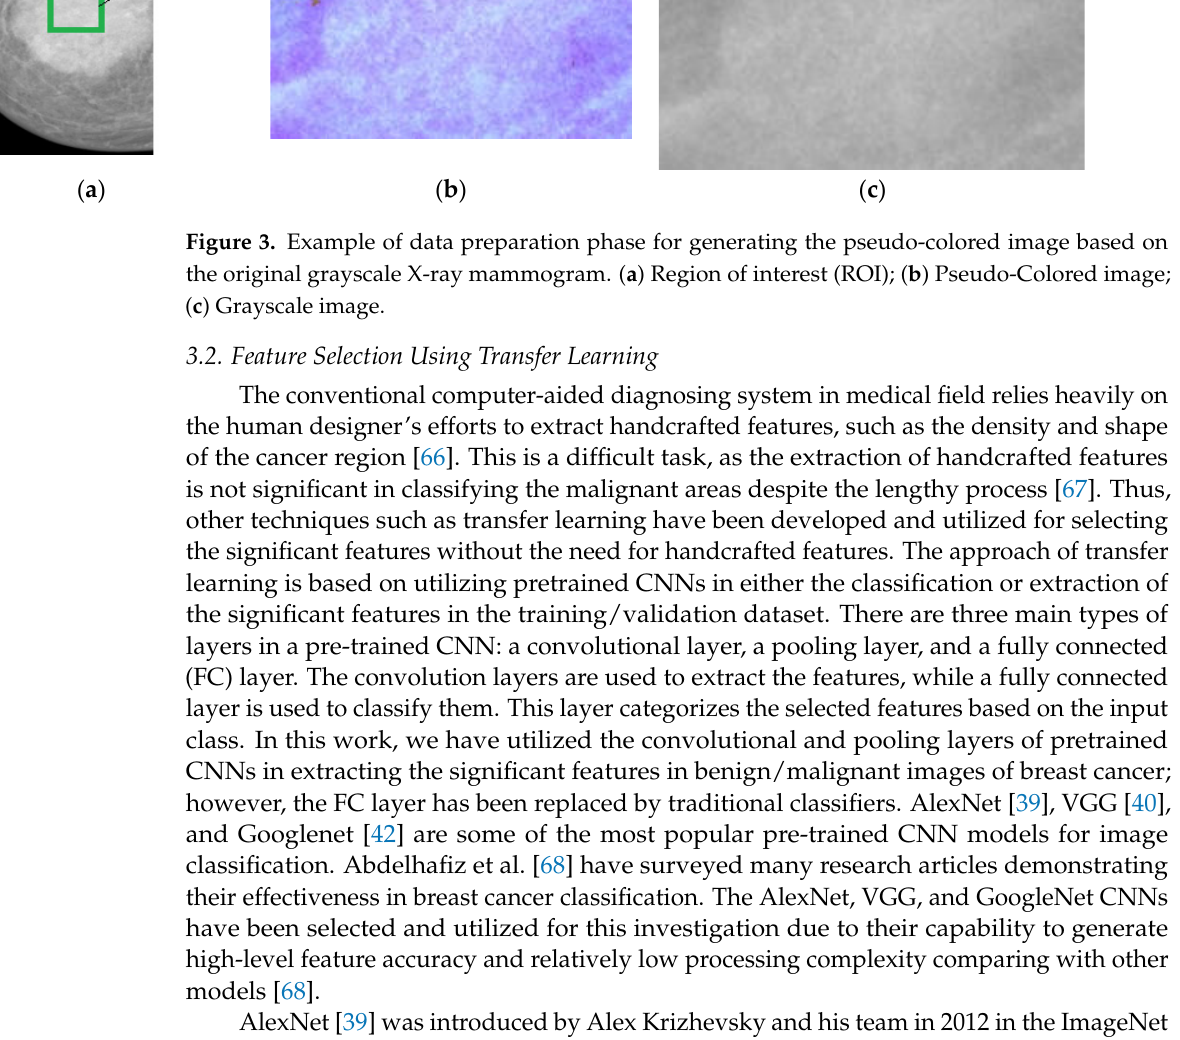
Figure 2. The concept of generating three-channel pseudo-color mapping image.